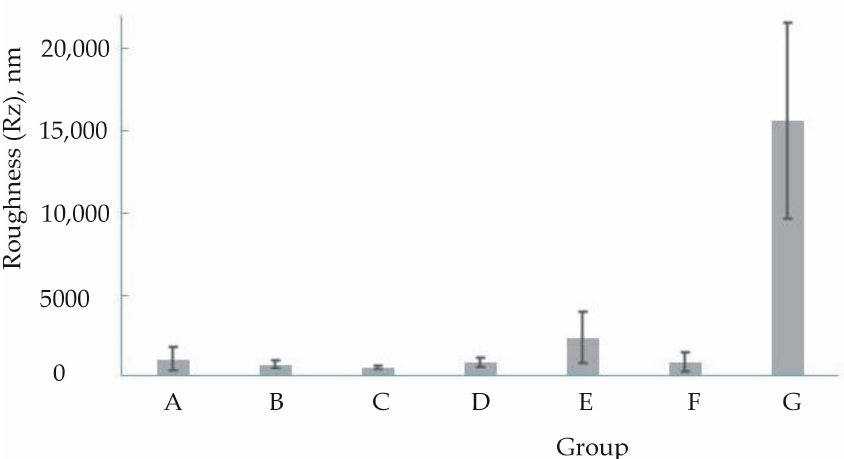
Figure 4. Mean value and standard deviation for roughness (Rz).